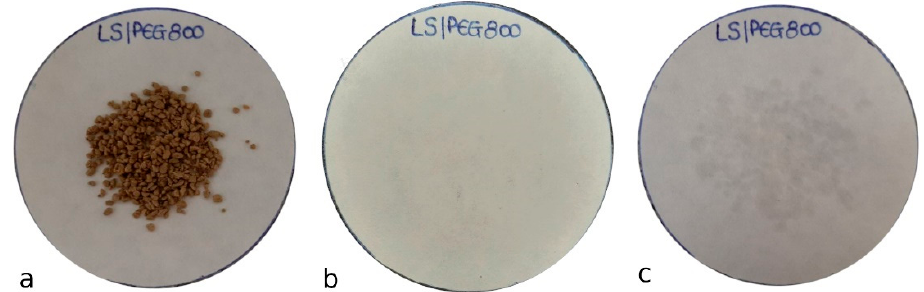
Figure 4. ( a ) LS/PEG800 PCM (5 g) placed on the filter paper, which had been previously weighed; ( b ) filter paper after the test performed at 30–35 °C; ( c ) filter paper after the test performed at 70–75 °C.